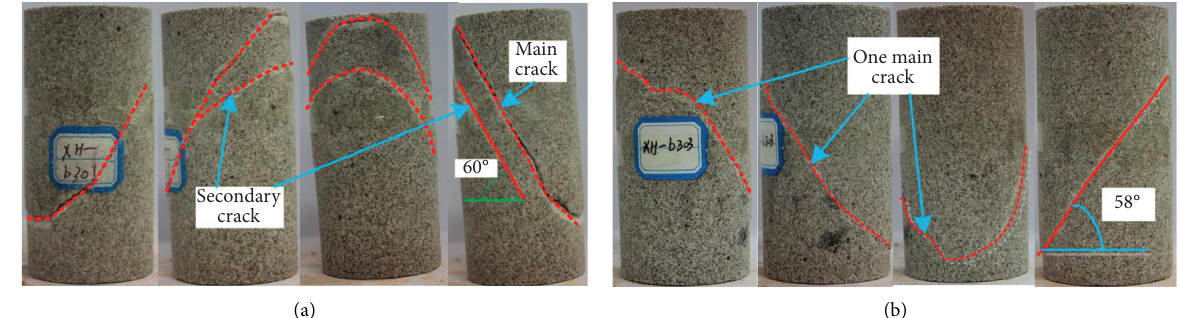
Figure 12: Failure pattern of the sample. (a) Scheme 1. (b) Scheme